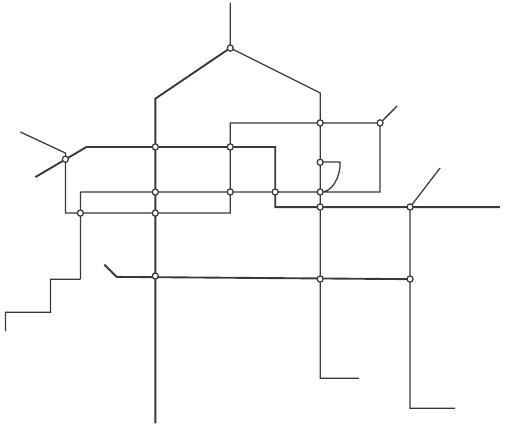
Figure 3: Guangzhou Metro Map